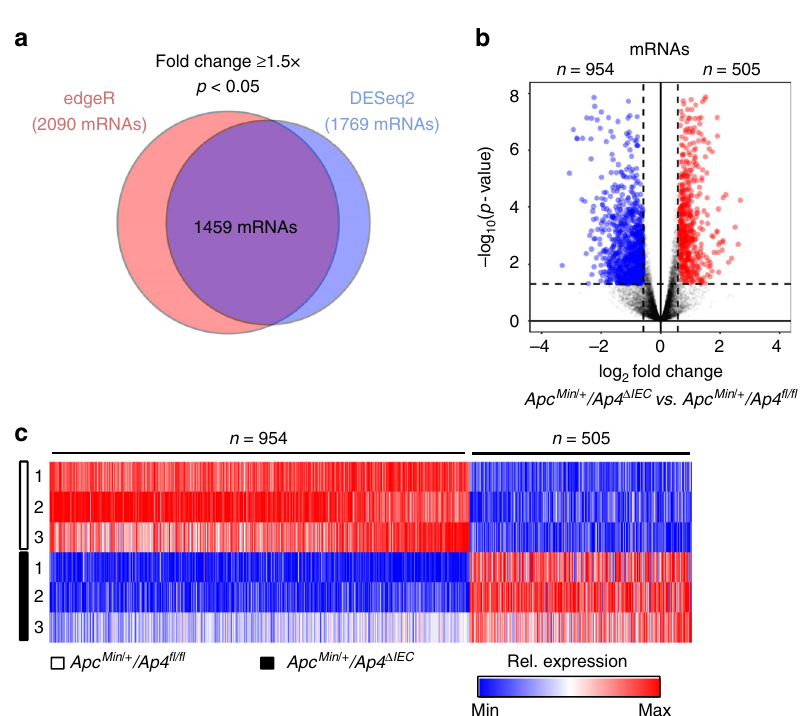
MaxRel. Min Fig. 3 Expression analyses of AP4 -de fi cient adenomas from Apc Min/ + mice. a Venn diagram displaying differentially regulated RNAs (fold change ⩾ 1.5, p < 0.05) in Ap4 fl / fl and Ap4 Δ IEC Apc Min/ + adenomas as determined by edgeR and DESeq2. b Volcano plot and heatmap depicting expression changes between Apc Min/ + / Ap4 fl / fl and Apc Min/ + /Ap4 Δ IEC tumors from 120 days old mice derived from three female mice ( fi ve tumors per mouse) per genotype detected by RNA-Seq. Volcano plot: p -values are plotted against the log 2 of the corresponding RNA expression changes in Ap4 Δ IEC versus Ap4 fl / fl adenomas. Differentially expressed RNAs ( p -value < 0.05) with a log 2 fold change ≥ 0.58 are indicated in red, with a log 2 fold change ≤ − 0.58 are marked in blue. RNAs with 0.58 > log 2 fold change > − 0.58 and/or with a p -value ≥ 0.05 are represented by gray dots. Dashed vertical lines indicate cut-offs for differential expression. Dashed horizontal line indicates the cut-off for adjusted p -values < 0.05 as determined with DESeq2. c Heatmap depicting expression changes of differentially expressed mRNAs (fold change ⩾ 1.5 and p < 0.05 as determined by edgeR and DESeq2) as relative expression levels normalized to the mean expression in the control, Apc Min/ + /Ap4 fl / fl , samples for each indicated mRNA. Colors indicate relative expression values from minimum (blue) to maximum (red) for each RNA sample per differentially regulated mRNA. Three biological replicates per genotype were